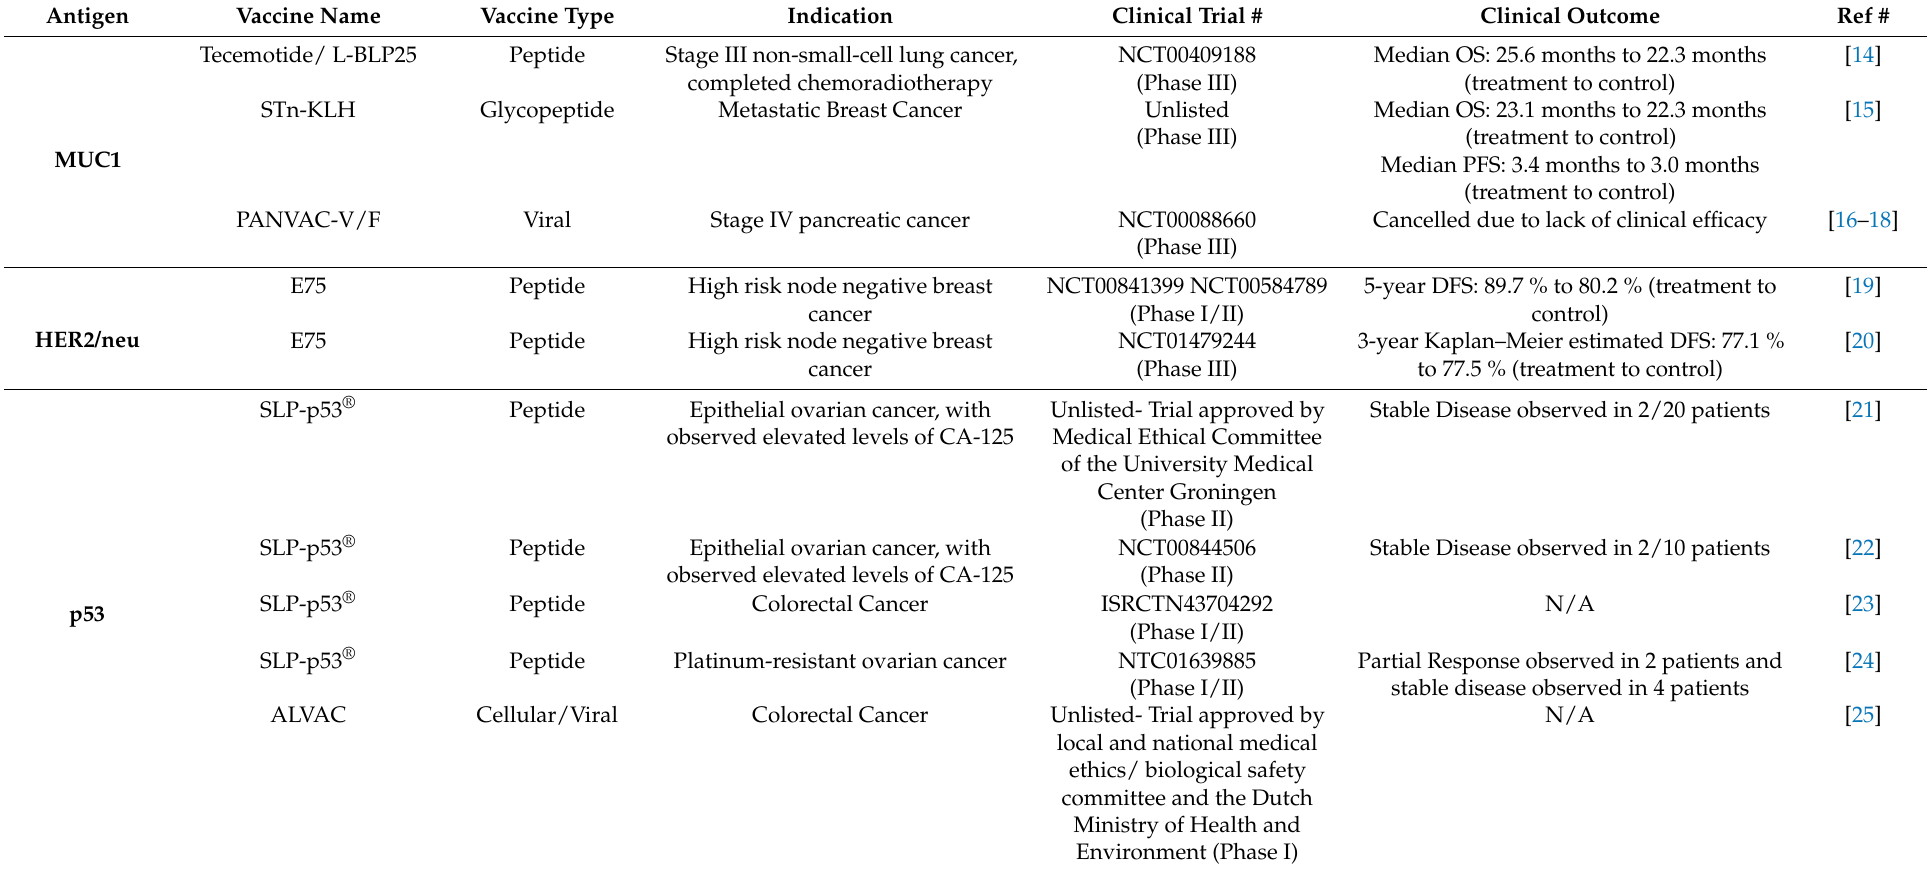
Table 1. Cancer vaccine Clinical Trials. Selection of most relevant cancer vaccine clinical trials including characteristics and